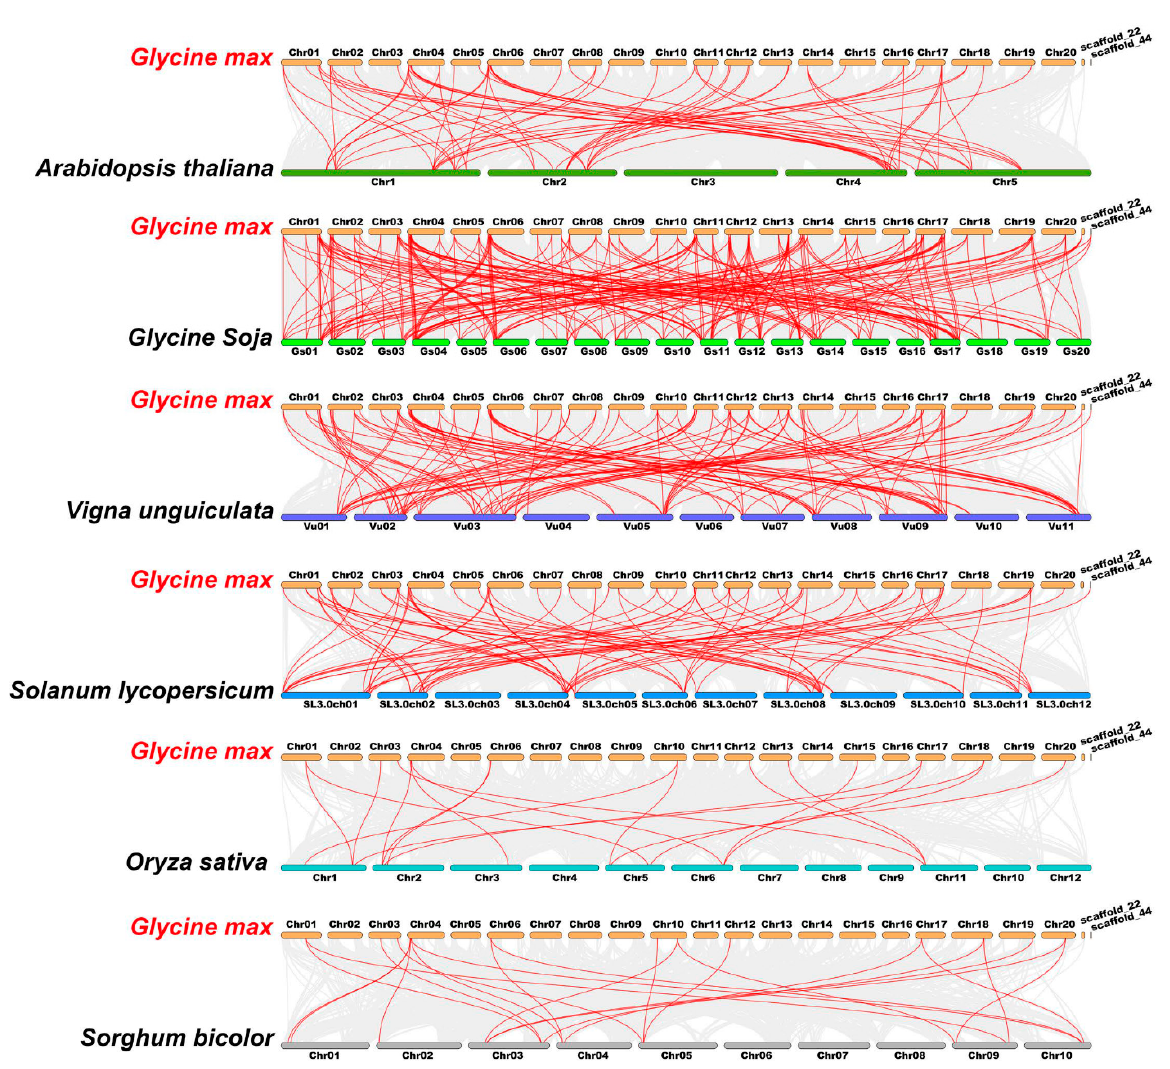
Figure 5. Syntenic relations of the TALE members among soybean and six representative plant species. Gray lines in the background indicated the collinear blocks within soybean and other plant genomes, and the red lines highlighted the syntenic GmTALE gene